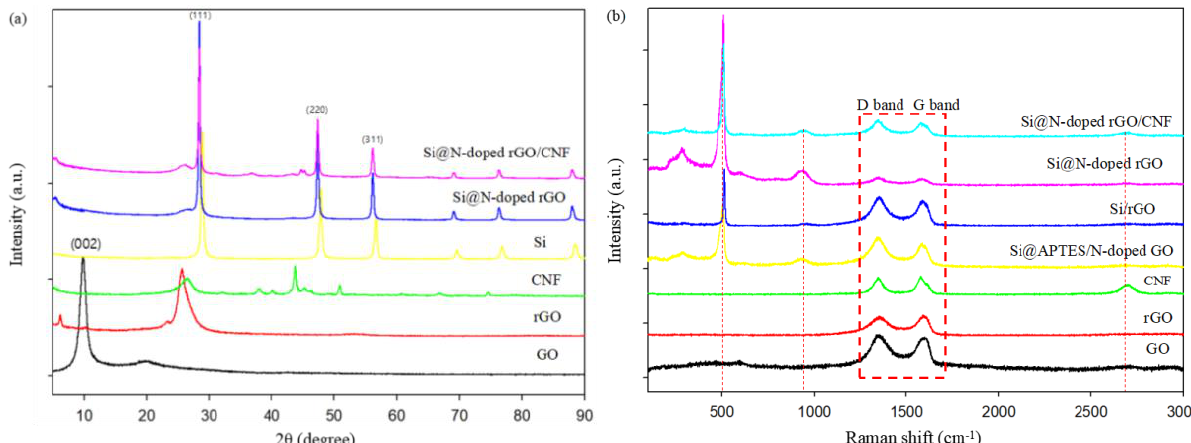
Figure 4. ( a ) X-ray diffraction patterns of GO, rGO, CNF, Si, Si@N-doped rGO, and Si@N-doped rGO/CNF, ( b ) Raman spectra of the GO, rGO, CNF, Si@APTES/N-doped GO, Si/rGO, Si@N-doped rGO, and Si@N-doped rGO/CNF.